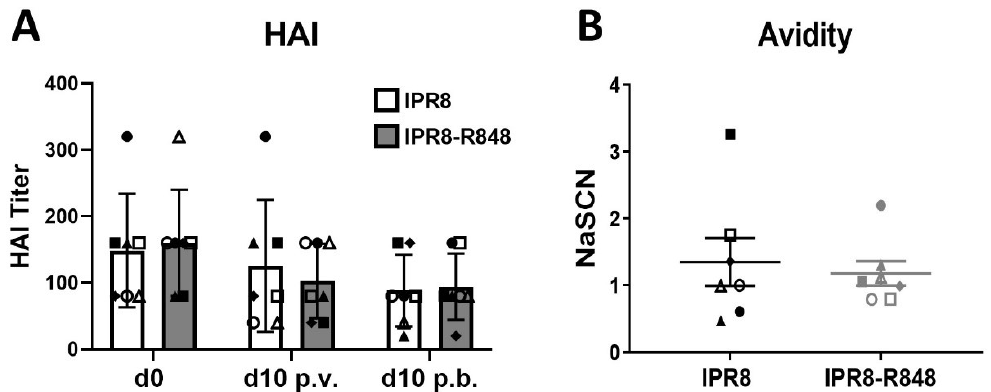
Figure 3. R848 adjuvantation does not improve the neutralizing capacity or avidity of IAV-specific antibodies after prime/boost vaccination in elderly AGM. ( A ) The neutralizing capacity of IAV-specific antibodies was assessed by HAI assays at d0, d10 p.v. and d10 p.b. Serially diluted plasma was incubated with PR8 for 30 min and then transferred to chicken red blood cells for hemagglutination assessment. HAI titer is defined by the highest dilution at which the sample prevents agglutination. Each animal is designated a distinct symbol; these symbols are consistent across time points to allow for longitudinal visualization of each individual response. IPR8- and IPR8-R848-vaccinated animals are designated by black or grey symbols, respectively. ( B ) The average avidity of PR8-specific IgG at d21 p.b. was calculated by determining the NaSCN concentration that gave a 50% reduction in optical absorbance compared to the untreated sample. Seven animals were included in each vaccine group, and the averages shown are the mean ±SEM. Statistical significance was determined using a two-way ANOVA with repeated measures and Tukey’s multiple comparisons test ( A ) or an unpaired two-tailed t-test ( B ). No statistical significance was observed, and the p -value was >0.05.